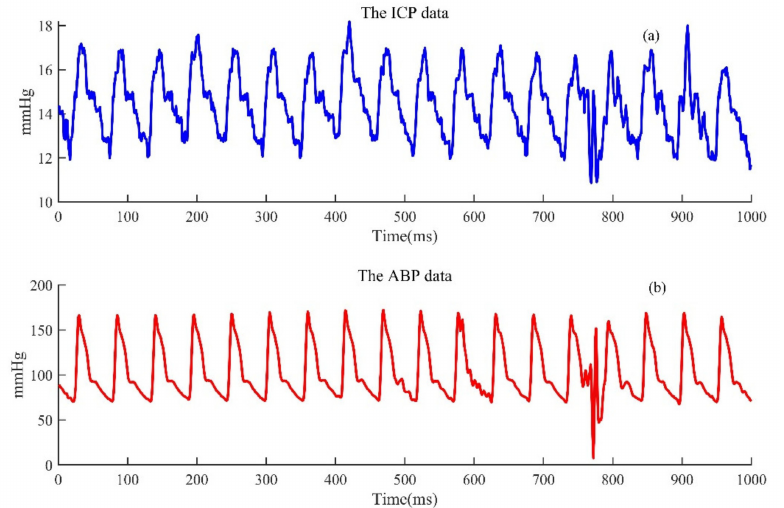
Figure 5. The system output and system input for parameter estimation. ( a ) The original output waveform with outlier influence. ( b ) The original input waveform with outlier influence.